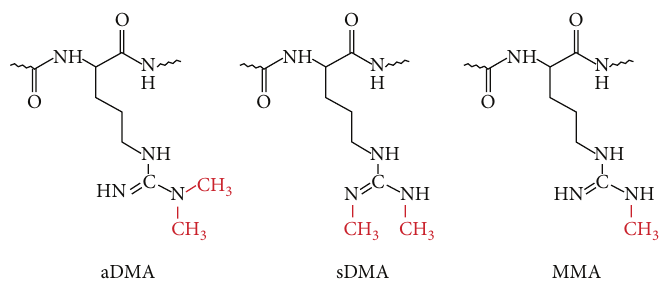
Figure 1: Conformation of three different methylarginines.